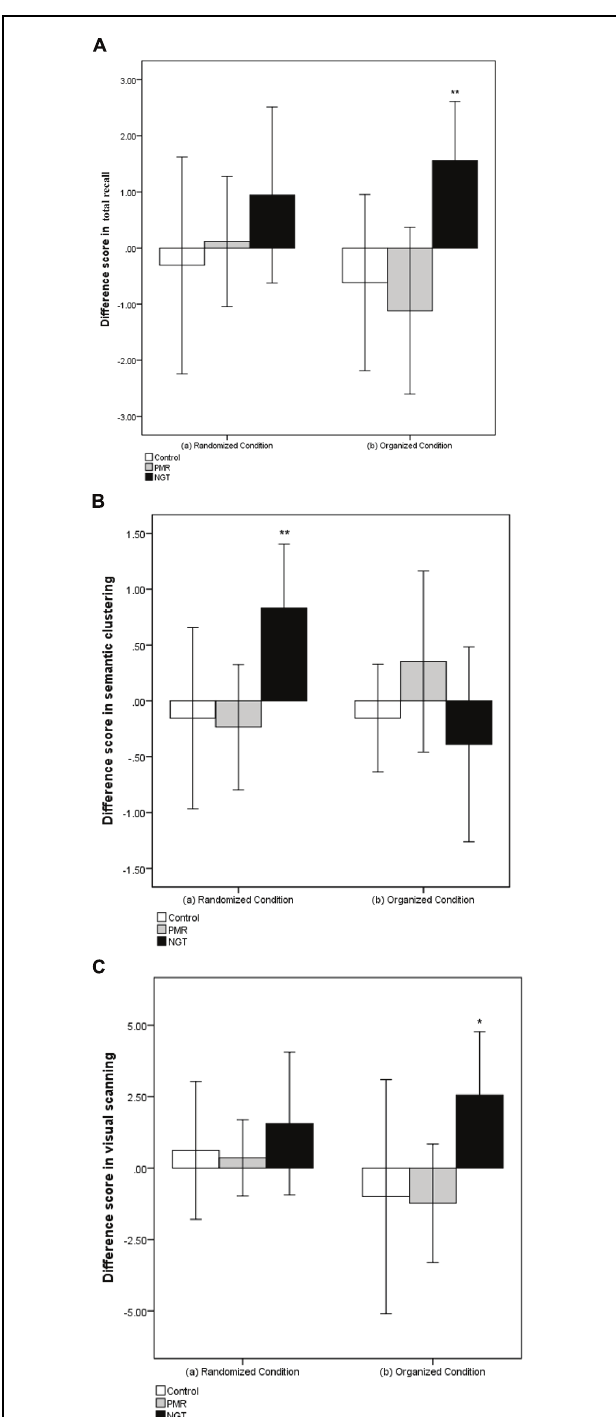
FIGURE 2 | Post-training score minus pre-training score in (A) total recall, (B) semantic clustering, and (C) visual scanning in randomized and organized conditions. Positive values indicate improved performance. The error bars represent 95% confidence interval of the difference between pre- and post-training scores. Control, control group without training; PMR, progressive muscle relaxation; NGT, Nei Gong training. ∗ p < 0.05; ∗∗ p < 0.01 (paired samples t